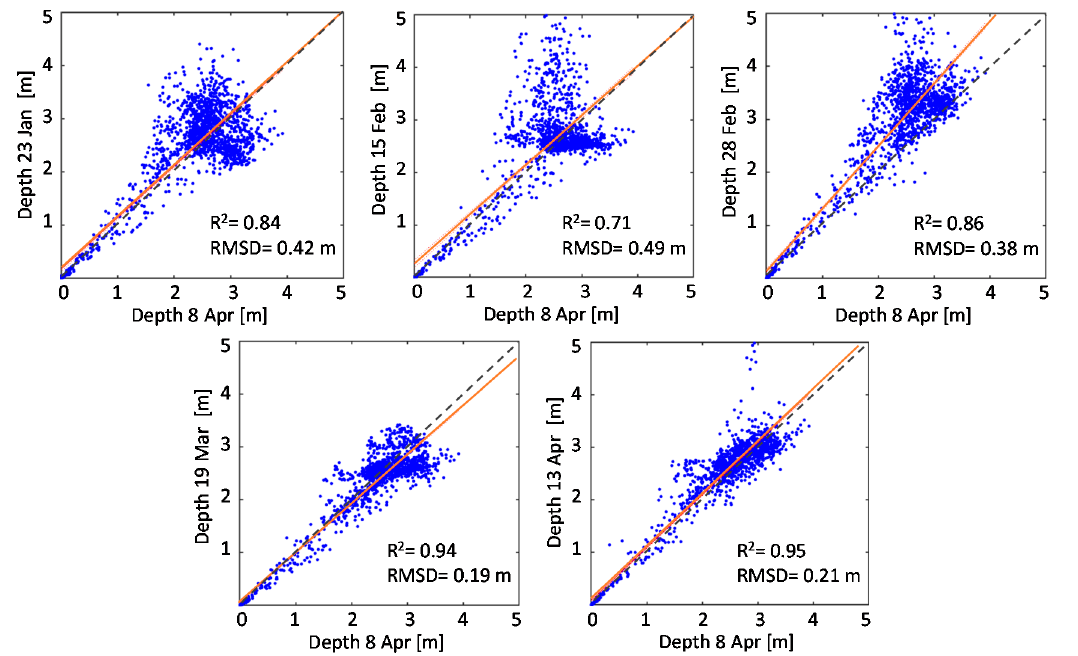
Figure 6. Comparison of the derived water depths of all images with the reference bathymetry map from 8 April 2020. Upper row: before lockdown; lower row: during lockdown.